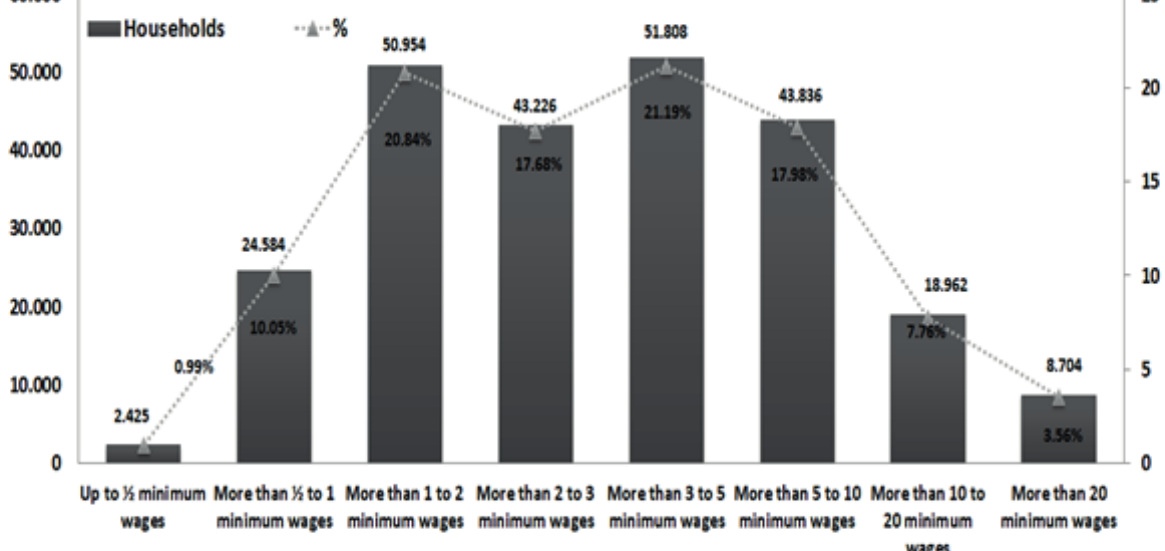
Figure 2. Distribution of the monthly income ranges of the Campo Grande households. Source IBGE